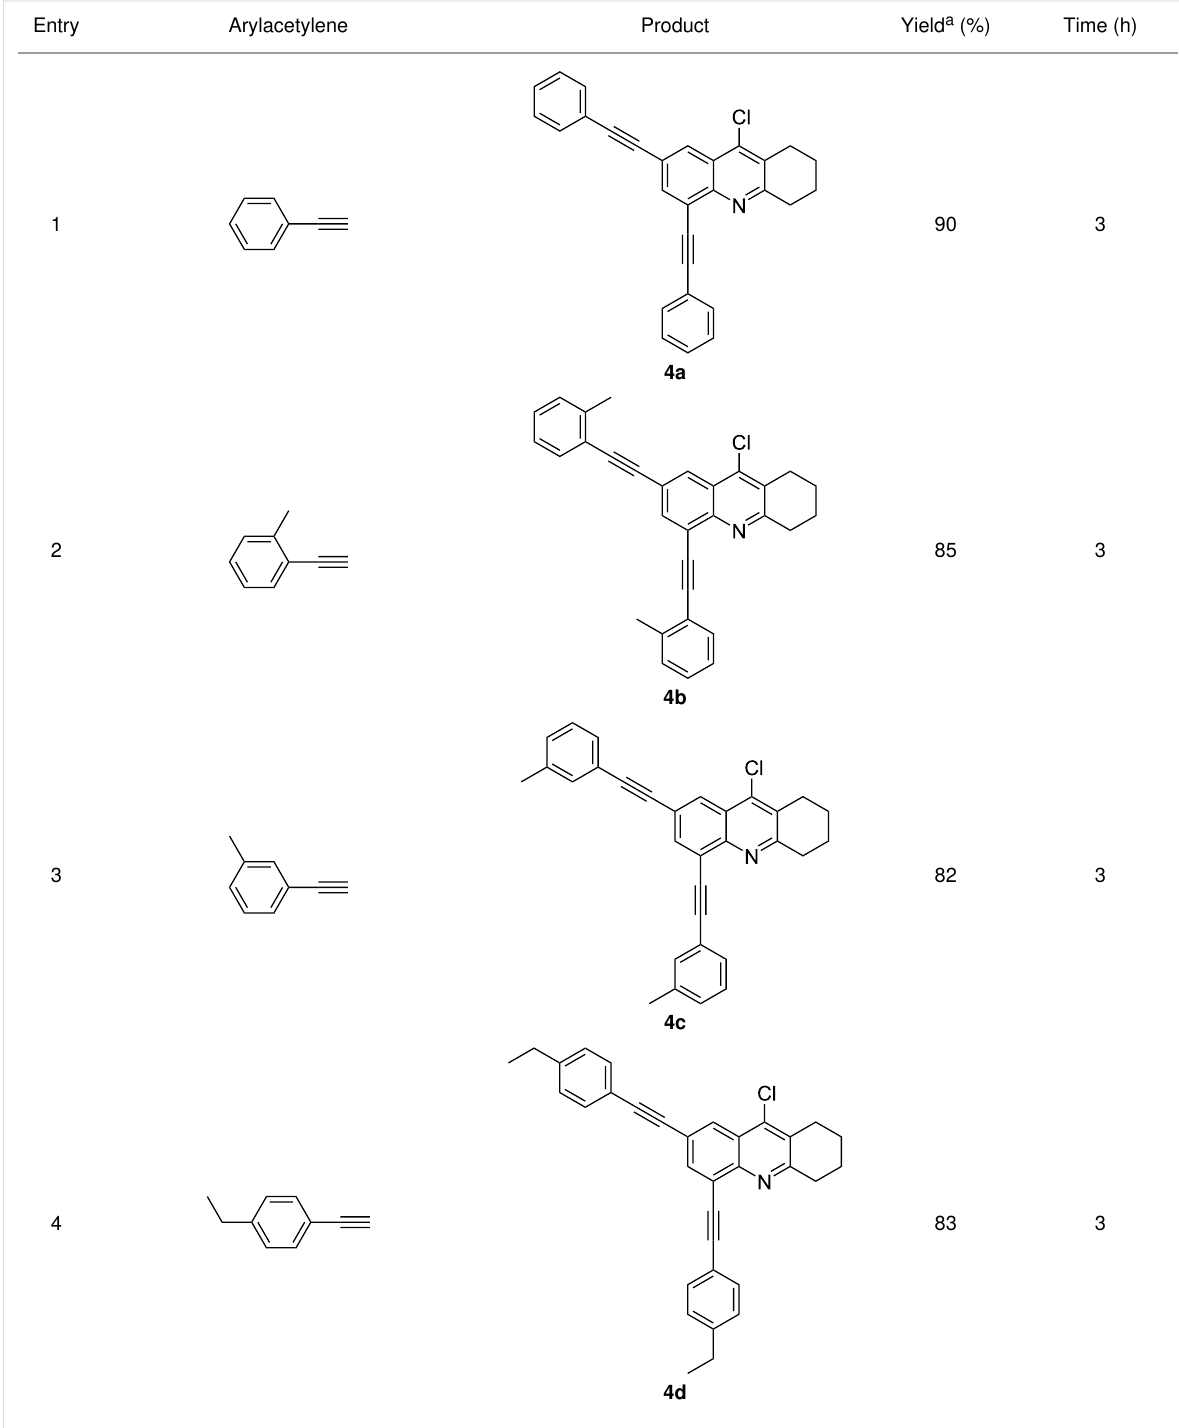
Table 2: Yields of 2,4-bis(arylethynyl)-9-chloro-5,6,7,8-tetrahydroacridine derivatives 4a–g . Entry